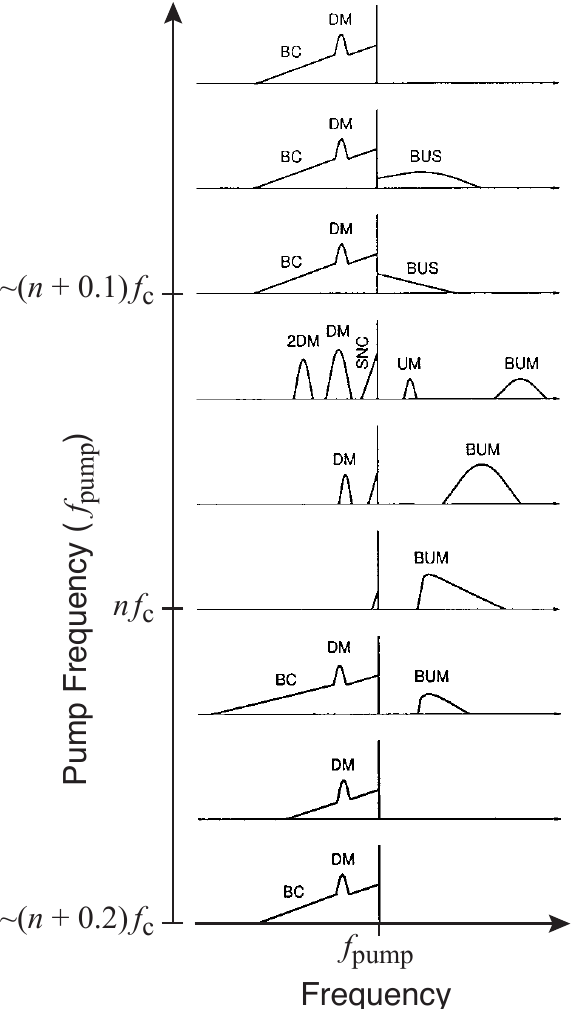
Fig. 6. Schematic depicting many of the major steady-state SEE features and their variation as a function of pump frequency f pump relative to the gyroharmonic frequencies, nf c , for n > 3, where f c is the electron gyro-, or cyclotron, frequency. The pump frequency is different in each panel, as indicated on the vertical axis; how- ever, the horizontal frequency scales of the individual panels have been shifted so that the different pump frequencies are aligned, as indicated on the bottom horizontal axis. In this way the dif- ferences in the nature of the SEE spectra as a function of offset from the pump can be illustrated as a function of changing pump frequency relative to the fourth and higher gyroharmonic frequen- cies. The features shown on this diagram are the broad contin- uum (BC), downshifted maximum (DM), broad upshifted structure (BUS), downshifted maximum first cascade (2DM), slow narrow continuum (SNC), upshifted maximum (UM), and broad upshifted maximum (BUM); note that the BUM marked in this figure is the BUM 2 (Frolov et al., 1998). Adapted from Leyser (2001), Fig. 32.